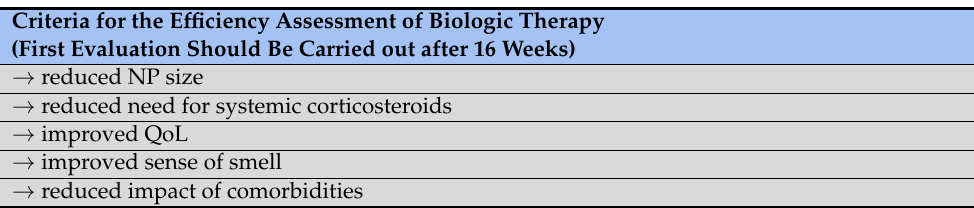
Table 2. Criteria for the efficiency assessment of biologic therapy according EPOS 2020 [2] (NPs— nasal polyps, QoL—quality of